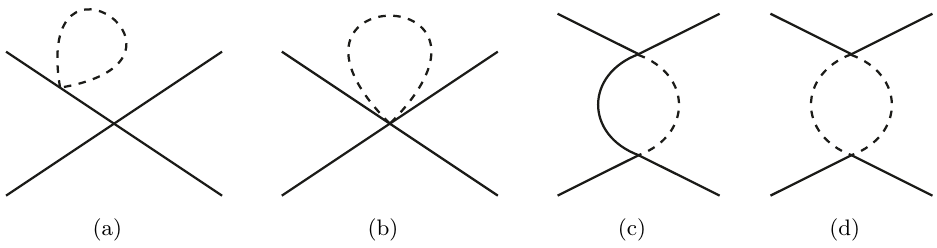
Figure 1 . Additional one-loop Feynman diagrams required to study two-pion scattering for the two channels of interest in U( N ) ChPT. Solid lines depict non-singlet mesons, while dotted represent f the η 0